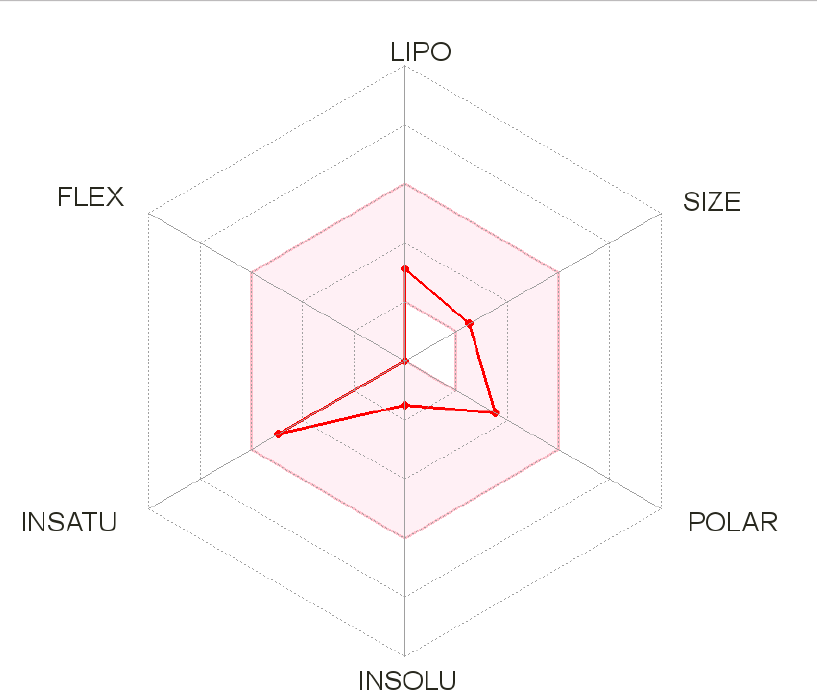
FIGURE 6 - Bioavailability radar of caffeine: the pink area represents the optimal range for each property (lipophilicity: XLOGP3 between -0.7 and +5.0, size: MW between 150 and 500 g.mol-1, polarity: TPSA between 20 and 130 (Å2), solubility: log S not higher than 6, saturation: fraction of carbons in the sp3 hybridization not less than 0.25, and flexibility: no more than 9 rotatable bonds. In this example, the compound is predicted not orally bioavailable, because too flexible and too